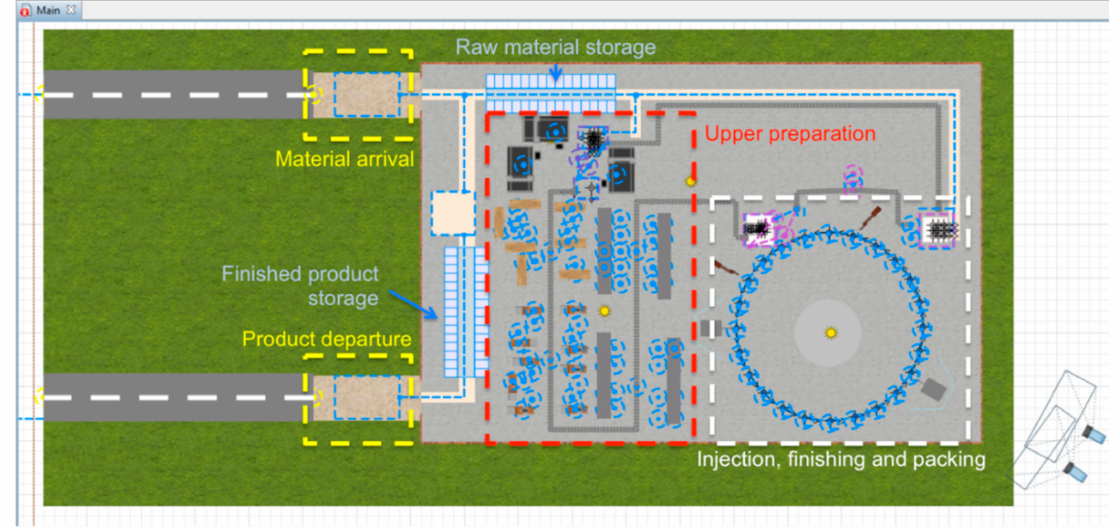
Figure 7. Spatial representation of the direct-injection